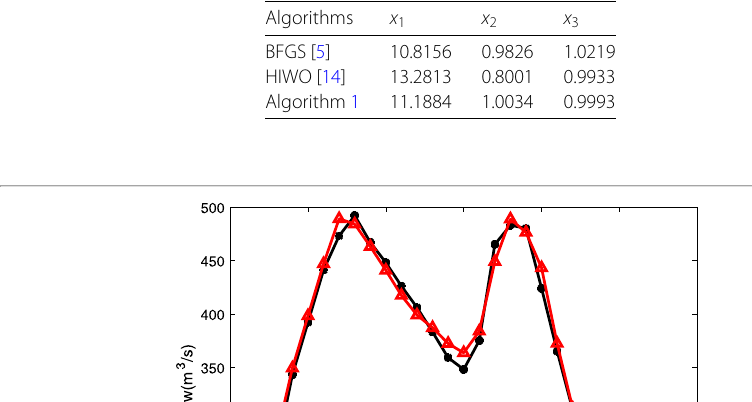
Figure 4 Performance of data in 1960